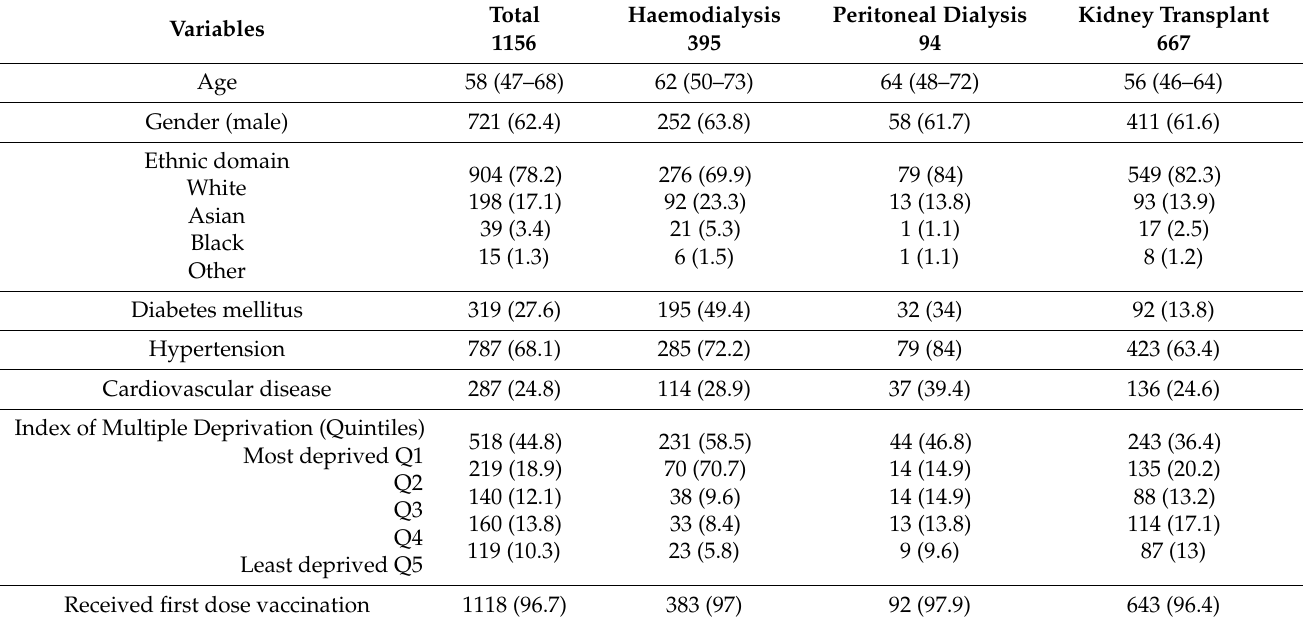
Table 1. Distribution of characteristics of the sample population.